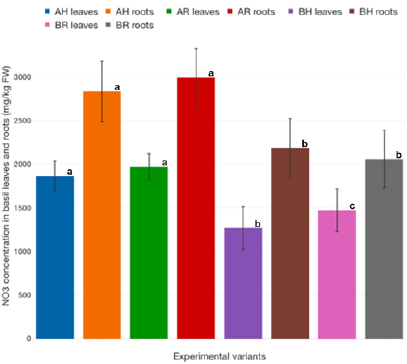
Figure 33. The concentration of NO 3 in basil roots and leaves biomass and SE, growth in each of the experimental variants (Tukey test) — different letters reveal significant statistical differences ( p < experimental variants (Tukey test)—different letters reveal significant statistical differences ( p < 0.05), 0.05), whereas the same letter reveal not significant statistical differences ( p > 0.05) whereas the same letter reveal not significant statistical differences ( p >